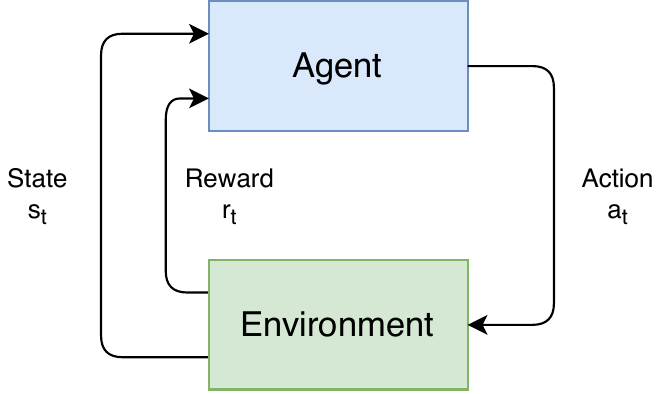
Figure 2. The reinforcement learning